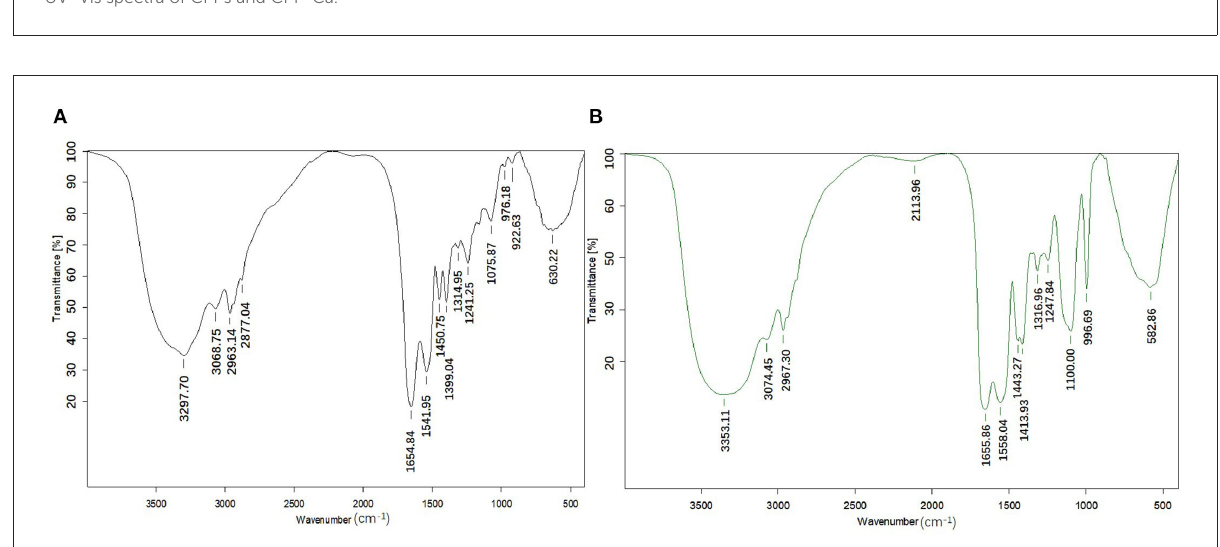
FIGURE3 Infrared absorption spectra of CPPs and CPP-Ca ( (A) CPPs; (B) CPP-Ca).